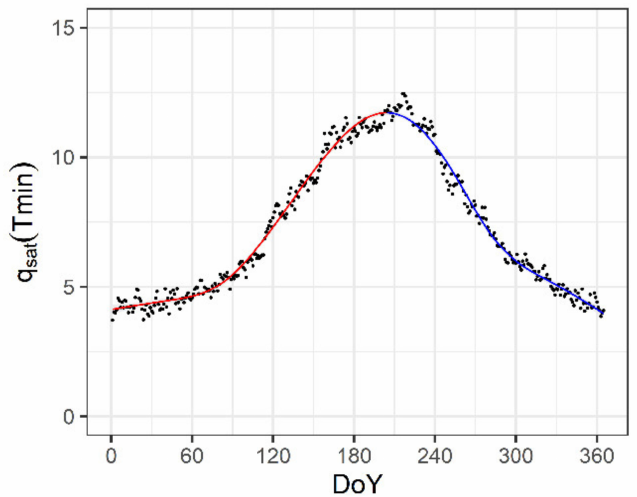
Figure 7. For the period 1990–2020, the daily averages of q sat ( T min ) (g kg − 1 ) for RS climate station (note the denotations used in all the following figures: observed (black dot) and GAM-fitted (red—increasing;